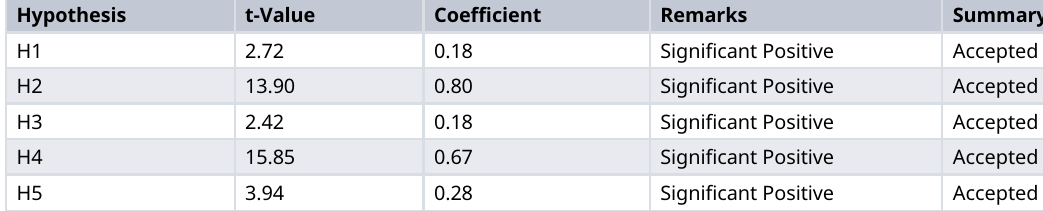
Table 3. Hypotheses testing result.